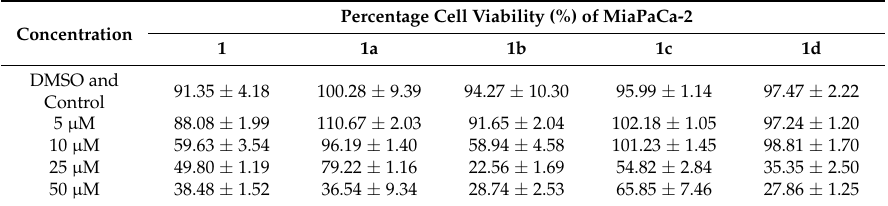
Table 2. Percentage cell viability (%) of MiaPaCa-2 of natural flavanone 1 and derivatives 1a , 1b , 1c and 1d . Concentration values are in µ M, and cell viability are expressed as mean ± SD. All data were obtained from three